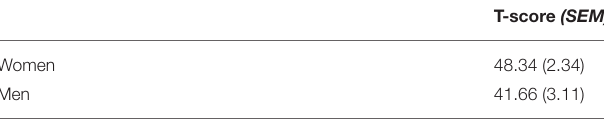
TABLE 3 | Mean scores of trait